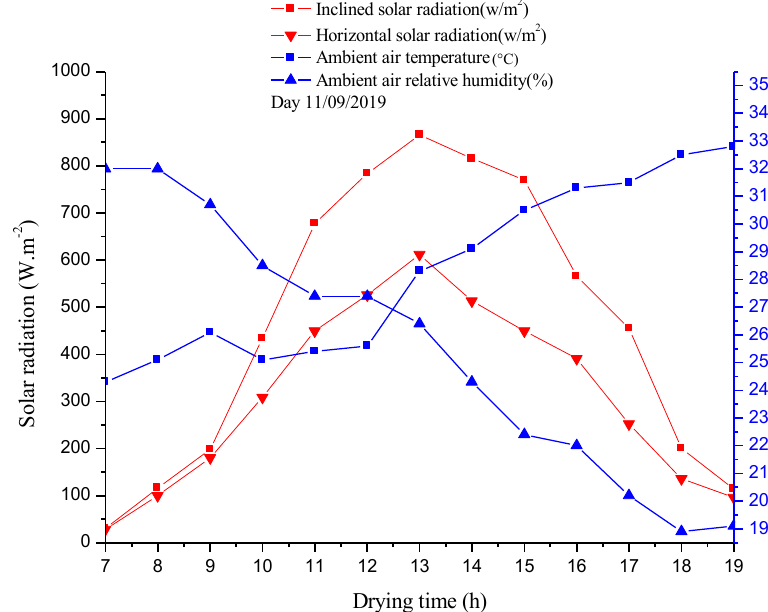
Figure 2. Variation of solar radiation versus daytime during the drying process.